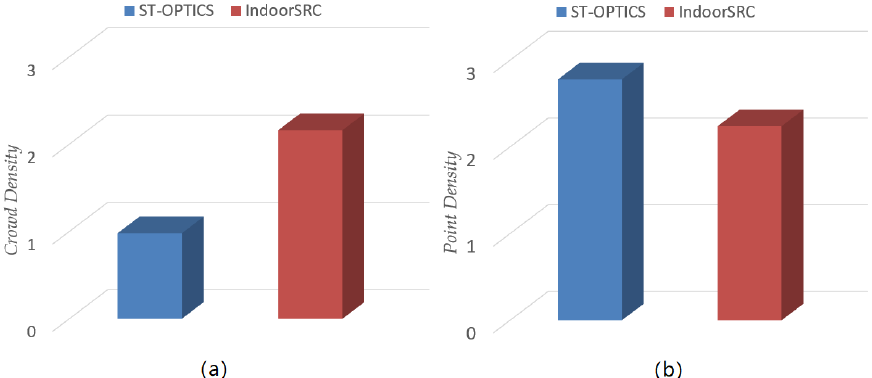
Figure 8. Comparison of the point density and crowd density with the baseline method: ( a ) crowd density comparison, ( b ) point density comparison.